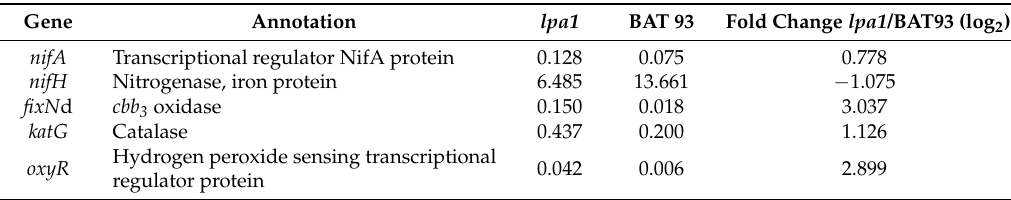
Table 1. Rhizobium etli bacteroids gene expression from low phytic acid ( lpa1) and BAT 93 plants under water stress treatment. ( p < 0.05).